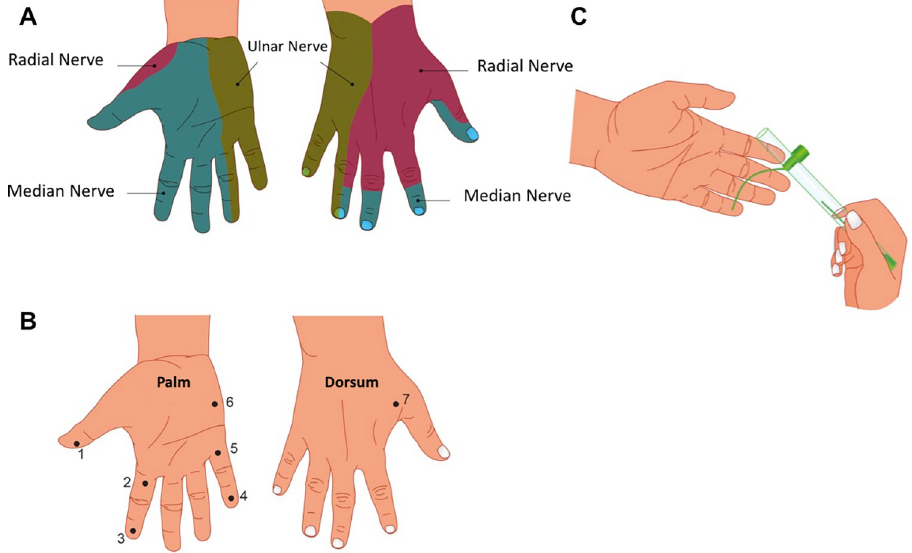
Fig 1. Dermatomes of the radial, ulnar and median nerves and the 7-SWM-test points tested on the hand. The normal tactile sensation threshold for the hand corresponds to the green monofilament (0.07 gf).